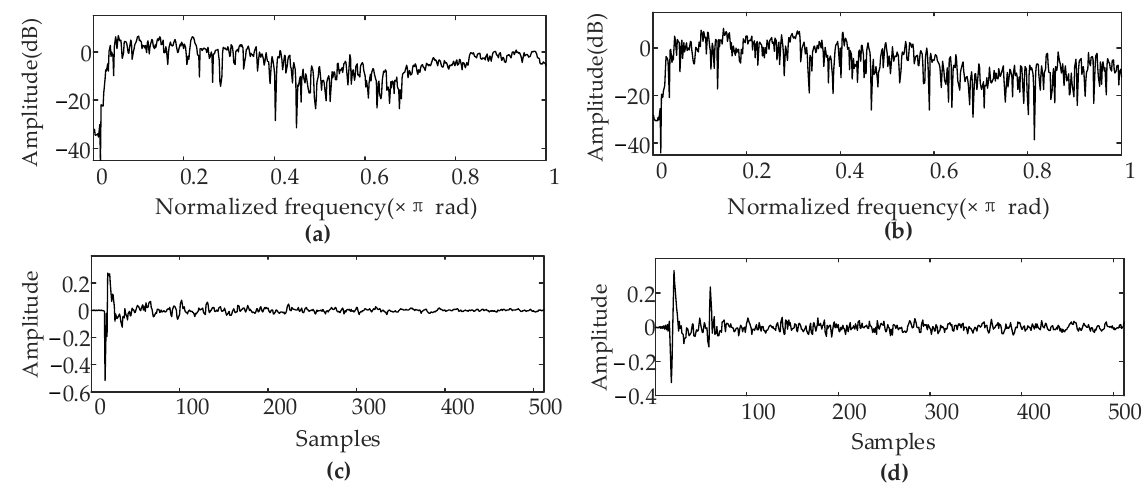
Figure 4. Acoustic feedback path: ( a ) frequency response (before switching); ( b ) frequency response (after switching); ( c ) impulse response (before switching); ( d ) impulse response (after switching).